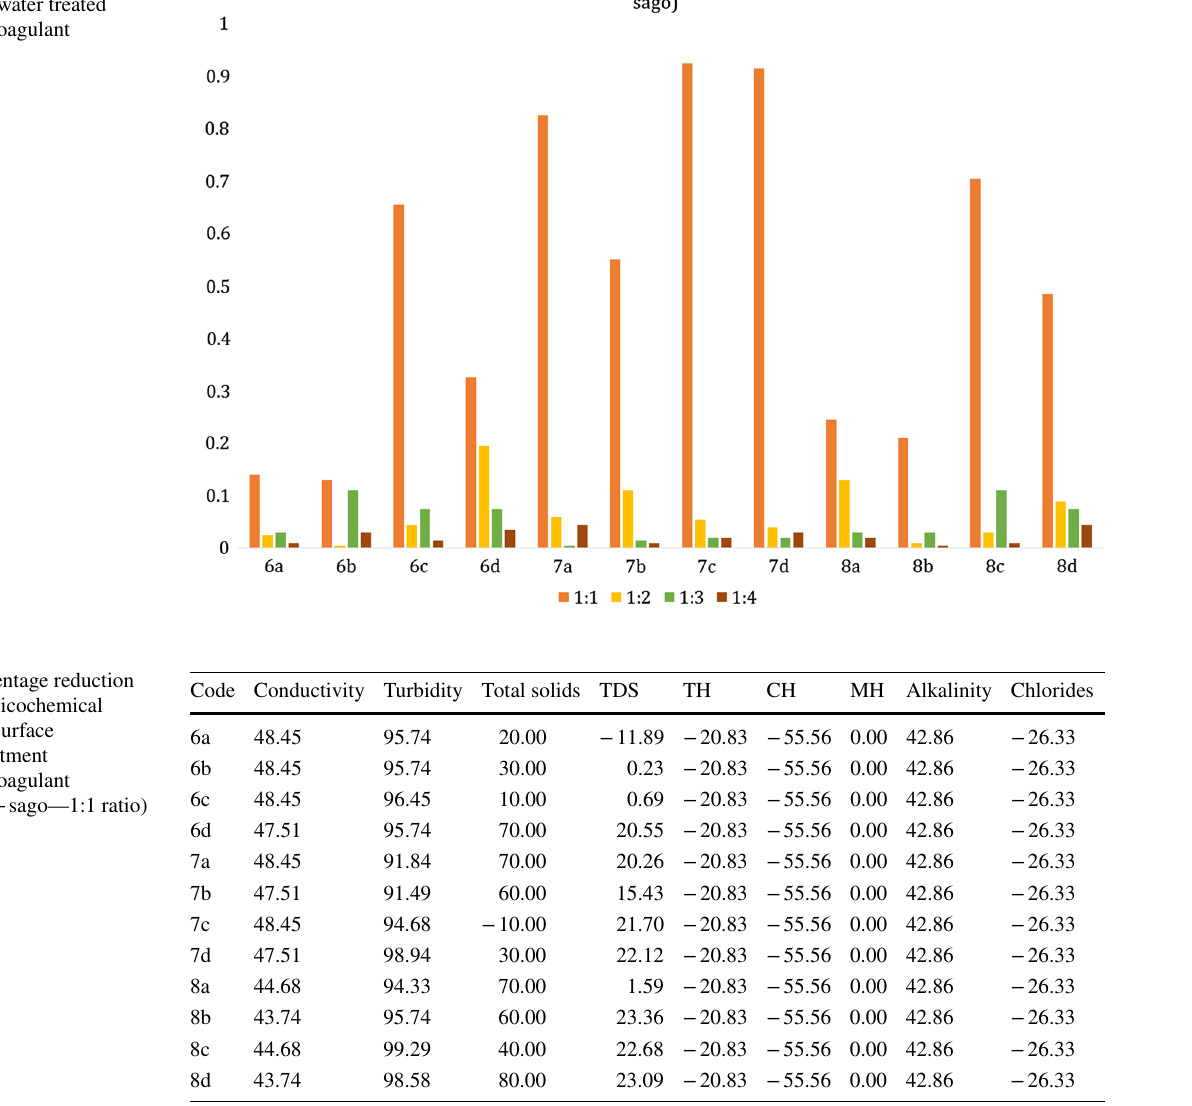
Fig. 3 Sludge weight (mg/l) obtained from water treated with blended coagulant (alum + sago)